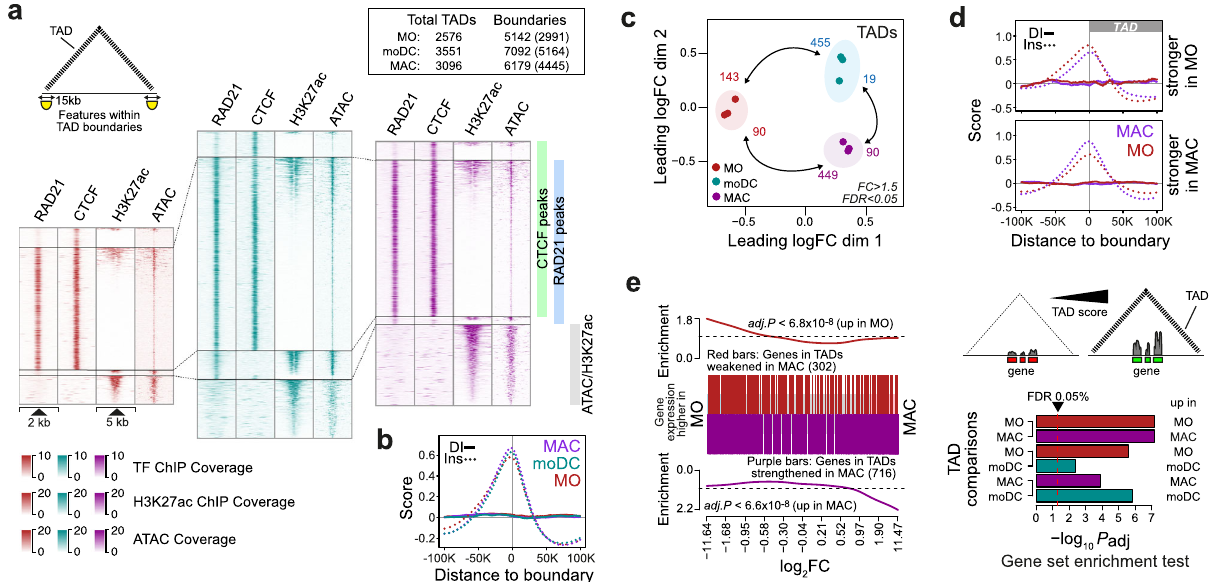
Fig. 2 Changes in topology-associated domains during MO differentiation correlate with gene expression changes. a Genomic distance distributions of RAD21, CTCF, H3K27ac ChIP-seq and ATAC-seq coverage at peak-centered boundaries of topology-associated domains (TADs) identi fi ed in MO, moDC and MAC. TAD boundary size is indicated in the schematic in the top left corner, where the triangular form indicates the TAD area. The numbers of TADs and non-overlapping boundaries are boxed in the upper right corner. The number of boundaries overlapping RAD21, CTCF, H3K27ac, or ATAC peaks are given in brackets. b Histograms of insulation scores (Ins, dotted lines) and directionality indices (DI, indicating preferences for contacts either upstream or downstream) across TAD boundaries in MO an MO-derived cells. c MDS plot comparing TAD score data sets of the indicated cell types. Numbers of signi fi cantly different TADs are indicated. d Histograms of insulation scores and directionality indices across differential TAD boundaries for MO versus MAC comparisons. e Gene set enrichment of differential TAD-associated genes. The enrichment of genes associated with cell type-speci fi c TADs (MO in red, MAC in purple) across all genes ranked by their expression difference in MO versus MAC is shown exemplary in the barcode plot in the left panel. Results of gene set enrichment testing for all MO, MAC, and moDC comparisons are summarized in the bar plot shown in the bottom right panel. Shown are adjusted P values (two-sided rotation tests, BH correction for paired testing), indicating that changes in TAD strengths tend to associate with accordant changes in the expression of TAD-overlapping genes, as depicted in the schematic on top of the bar plot. ( b , d , e ) Source data are provided as a Source Data fi